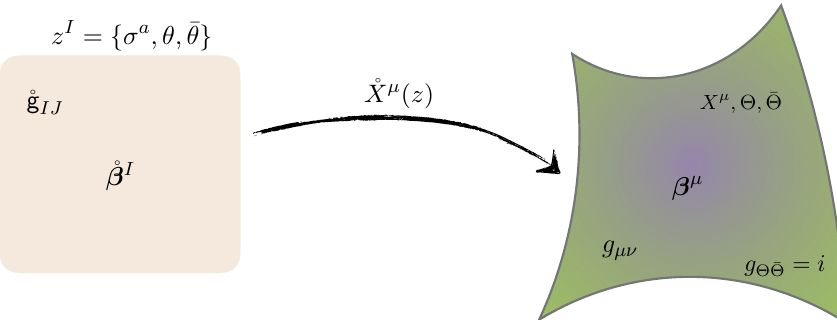
Figure 4 . Illustration of the data for hydrodynamic sigma models. The physical degrees of freedom are captured in the target space maps (cid:23) X (cid:22) ( (cid:27); (cid:18); (cid:22) (cid:18) ), along with the gauge condition which aligns the Grassmann coordinates in target space with their worldvolume counterparts (cid:2) = (cid:18) and (cid:22)(cid:2) = (cid:22) (cid:18) . The worldvolume geometry is equipped with a reference super-vector (cid:12)eld (cid:23) (cid:12) I , which pushes forward to the physical thermal vector in spacetime, while the spacetime metric g (cid:22)(cid:23) (with g (cid:2)(cid:22)(cid:2) = i ) pulls back to the worldvolume metric (cid:23) g IJ . The pullbacks and pushfowards are U(1) T gauge covariant, since the worldvolume dynamics is constrained by this